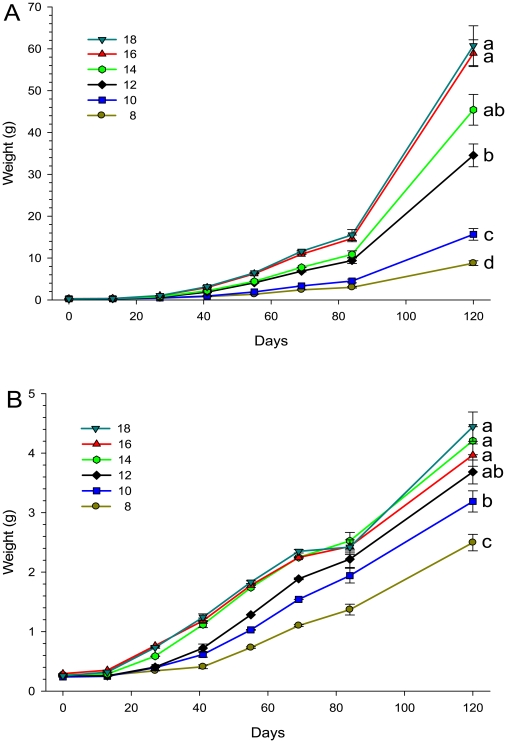
Growth of transgenic (A) and wild-type (B) coho salmon juveniles.Juveniles were reared from first-feeding until an age of 120 days at temperature from 8 to 18°C. Different letters denote significant differences at the p<0.05 level (Tukey's post hoc test) on ln-transformed values after 120 days (figures based on raw values). Note the more than 10-fold larger Y-axis scale for the transgenic fish.